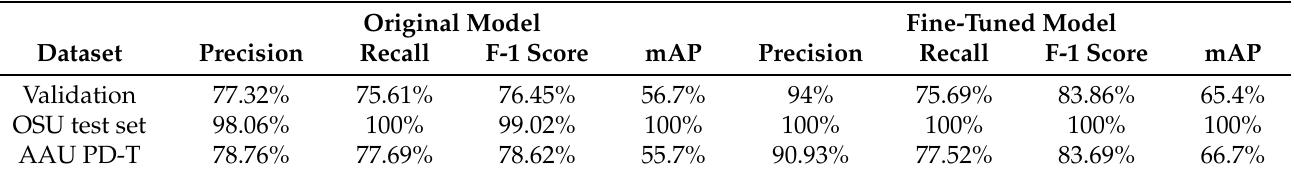
Table 5. Performance of Faster R-CNN ResNet50 model before and after fine-tuning.